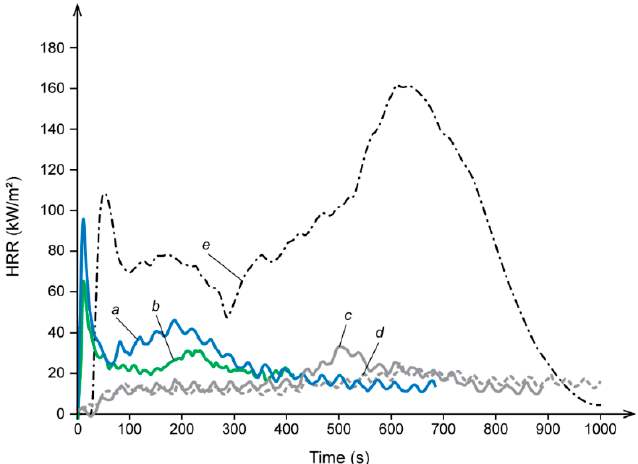
Figure 3. Comparison of heat release rate (HRR) of green roof substrates at dry and moist state with typical roof covering: ( a ) Substrate 1 (0% moisture content (MC)); ( b ) Substrate 2 (0% MC); ( c ) Substrate 1 (30% MC); ( d ) Substrate 2 (30% MC); ( e ) polymer-modified bitumen (PMB) membrane with fire retardants (redrawn from Bourbigot et al. [49]). A comparison can also be made to a membrane of the same material but without fire retardants.